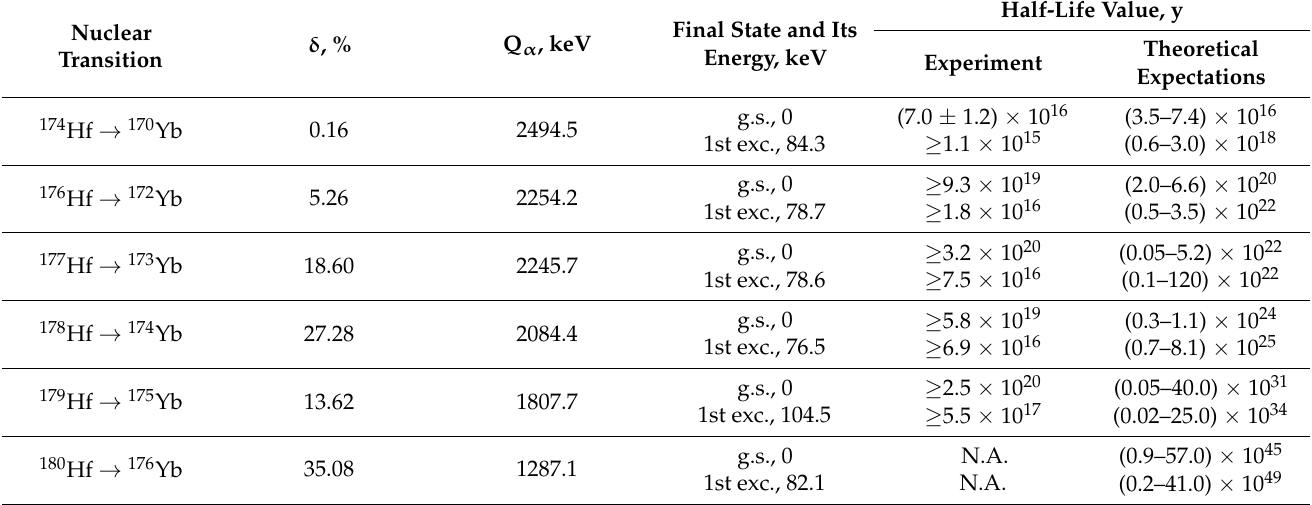
Table 7. Half-life values of rare alpha decays of natural Hf isotopes measured in [7], in comparison to theoretical estimations (estimations also grabbed from listed in [7]). Natural isotopic abundance ( δ ) and released energy (Q α ) in these transitions for the g.s. to g.s. decay mode are also listed. All limits are at 90% C.L “N.A.” means “not analyzed”.